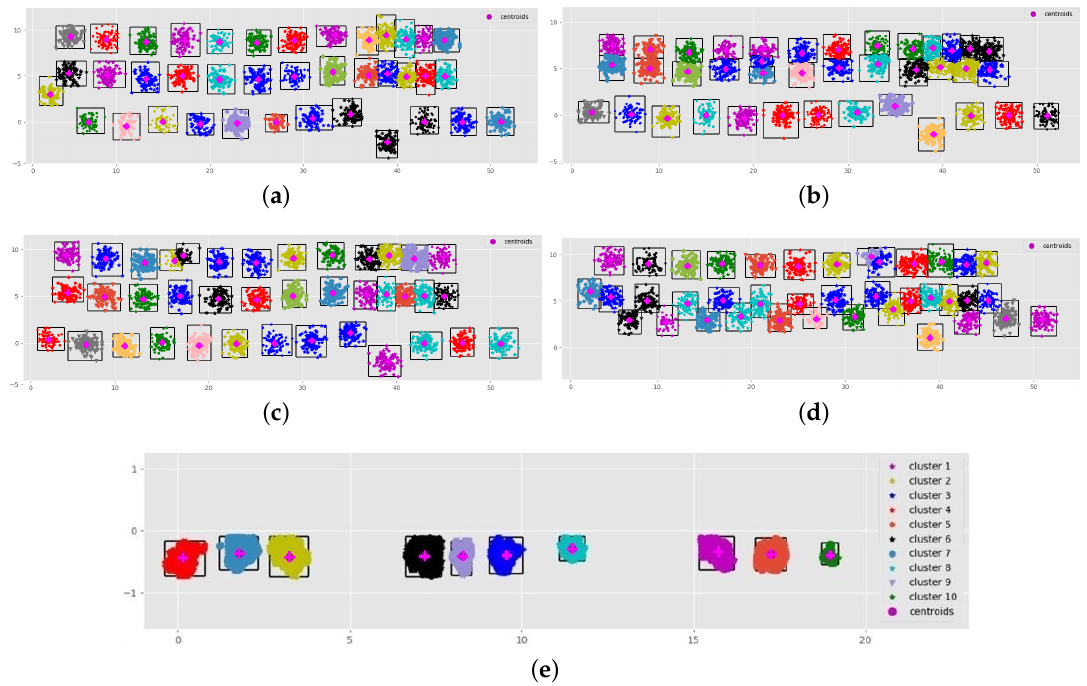
Figure 6. K-means classification and geometrical parameters extraction from synthetic and real data. ( a ) Synthetic data from 39 point clouds (distribution 1), ( b ) synthetic data from 39 point clouds (distribution 2), ( c ) synthetic data from 39 point clouds (distribution 3), ( d ) synthetic data from 39 point clouds (distribution 4), ( e ) real data from row cultivation. Source: